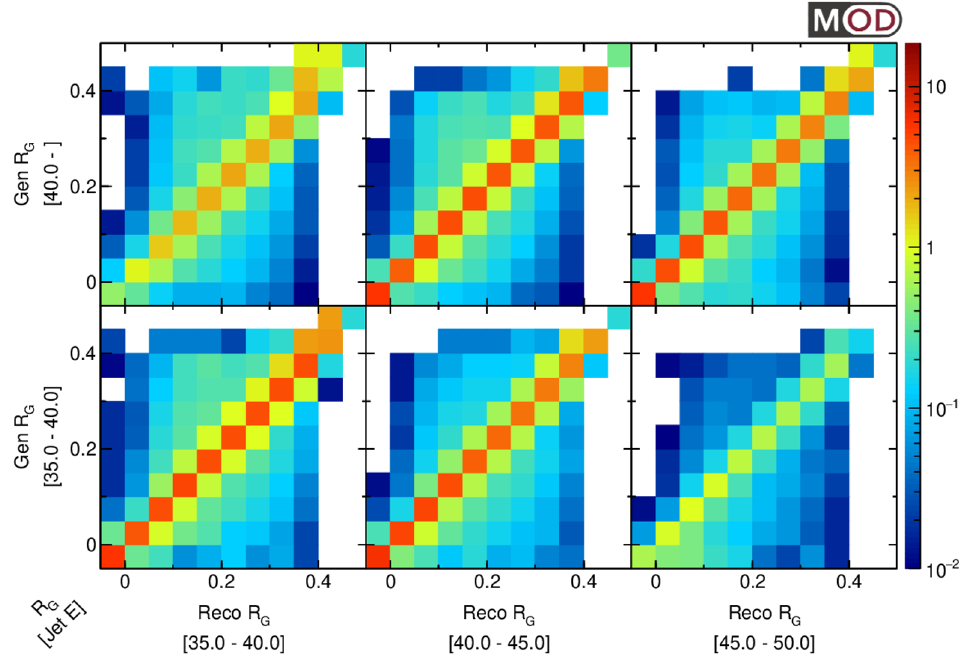
Figure 3 . Partial response matrix for R G , in bins of jet E . Each block is the sub-matrix for the indicated jet E range. The matrix is row-normalized across all jet E ranges: the color scale indicates the probability density of a given generator level (“Gen”) jet being smeared into a different reconstructed level (“Reco”)